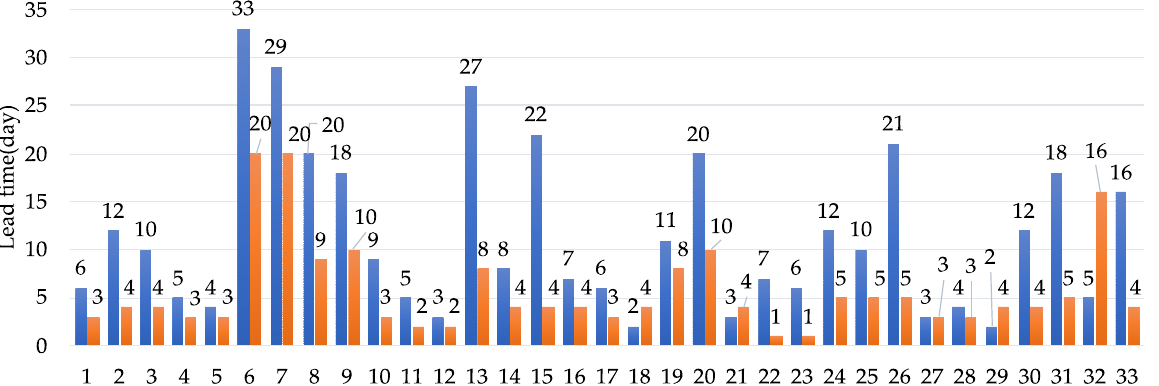
Figure 1. Differences in planned and actual lead times.